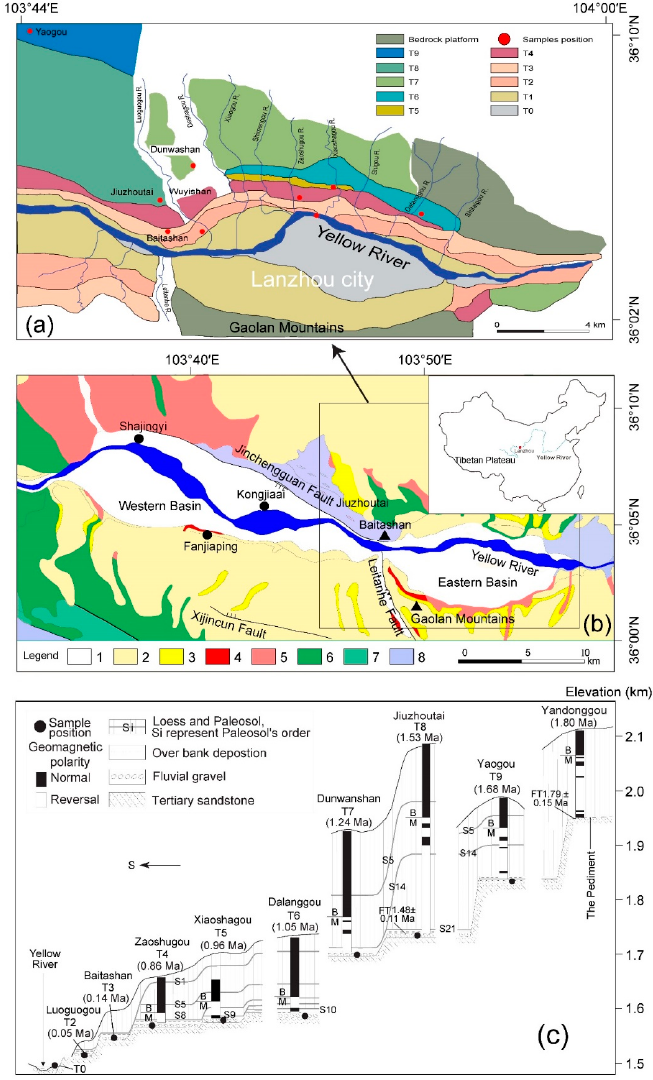
Figure 1. Yellow River terraces in the Lanzhou area. ( a ) Terraces distribution and sample location (modified from [10,38]). ( b ) Geological map of the Lanzhou area (modified from [19,21]). Geological units: 1: Holocene fluvial sediments; 2–3: Pleistocene loess-paleosol sequence; 4: Wuquan fluvial gravel formation; 5: Tertiary sandstone and glutenite; 6: Cretaceous purplish-red sandstone and greyish green siltstone; 7: Ordovician greyish green andesite and meta-andesite; 8: Precambrian basement. ( c ) Syntheses of stratigraphic and chronological data from loess-paleosol sequences covering terrace surfaces. The terraces’ ages were obtained by measuring the magnetostratigraphy (T9–T4) and optically stimulated luminescence (OSL, T3–T2) dating of loess-paleosol sequences covering these terraces (modified from